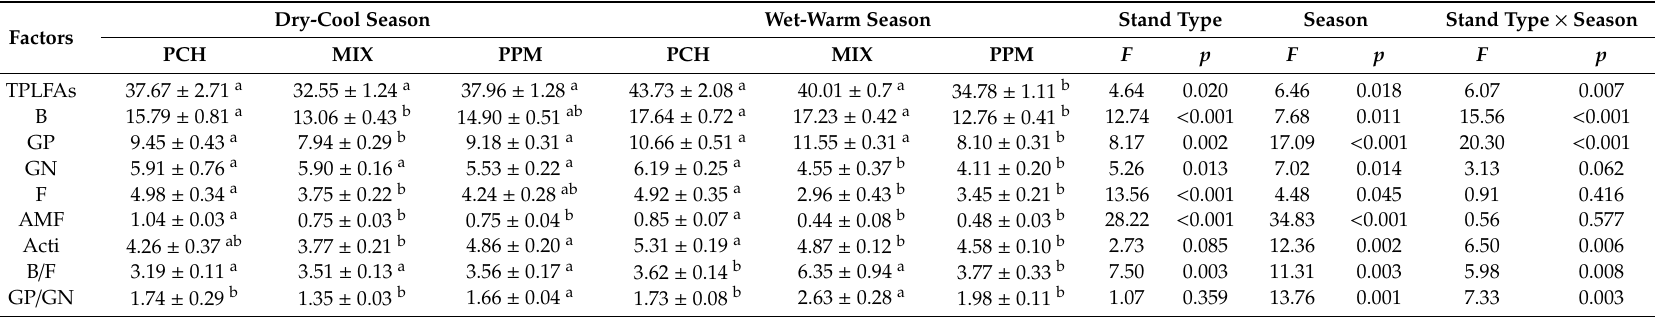
Table 4. Soil microbial community PLFAs content and structure (0–10 cm soil depth) in pure Castanopsis hystrix (PCH) plantation, pure Pinus massoniana (PPM) plantation, and mixed C. hystrix and P. massoniana (MIX) plantation (mean ± standard error; n = 5). Dry-Cool Season Wet-Warm Season Stand Type Season Stand Type × Factors